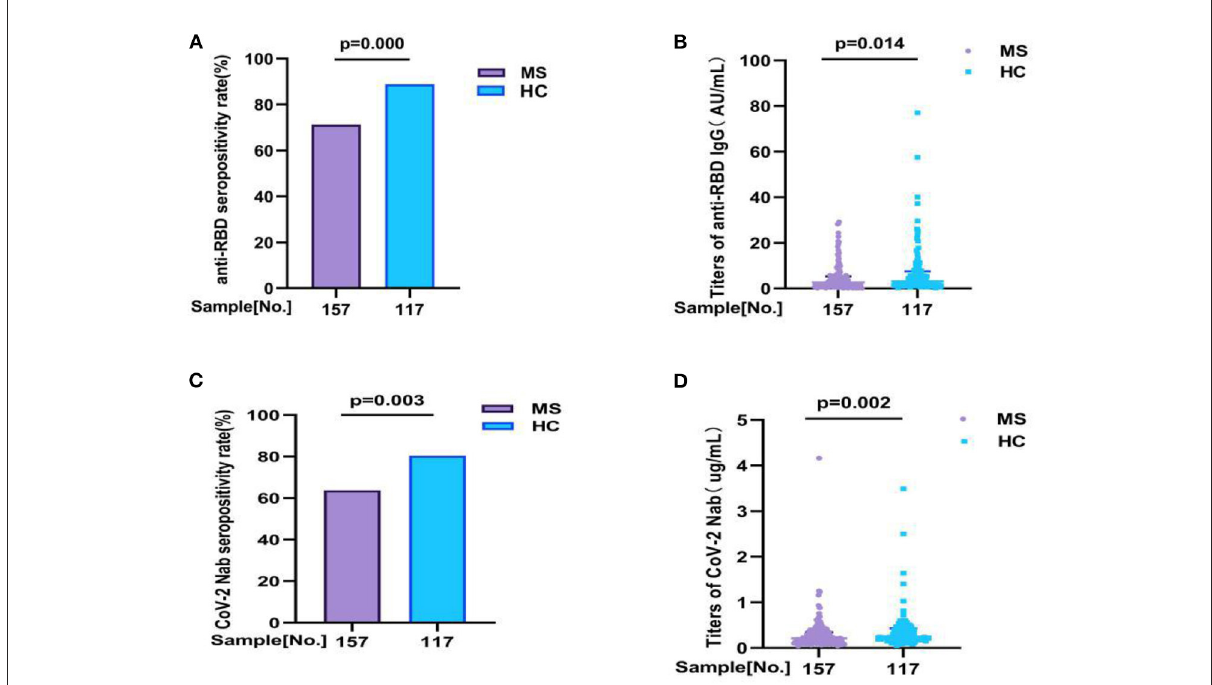
FIGURE1 The antibody responses to inactivated COVID-19 vaccine in MS and HC. The antibody responses to inactivated COVID-19 vaccine in MS and HC. Overall, compared with HC, (A,B) the seropositivity rate of anti-RBD IgG and CoV-2 Nab was significant lower in MS patients (71.3 vs. 88.9%, p = 0.000, 63.70 vs. 80.34%, p = 0.003, respectively). Similarly, (C,D) the titers of anti-RBD IgG and CoV-2 Nab were also significant lower in MS patients: 2.650 (0.840, 5.300) vs. 3.150 (1.655, 7.550), p = 0.014; 0.210 (0.120, 0.345) vs. 0.250 (0.170, 0.430), p = 0.002, respectively. Titers were presented as median (IQR) (data are shown in Supplementary Table